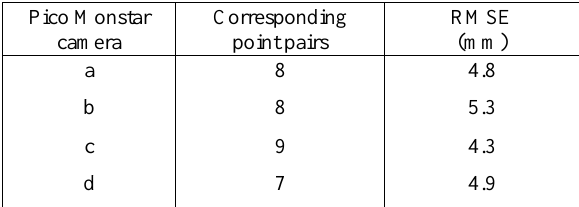
Table 2. Target-based registration precision.